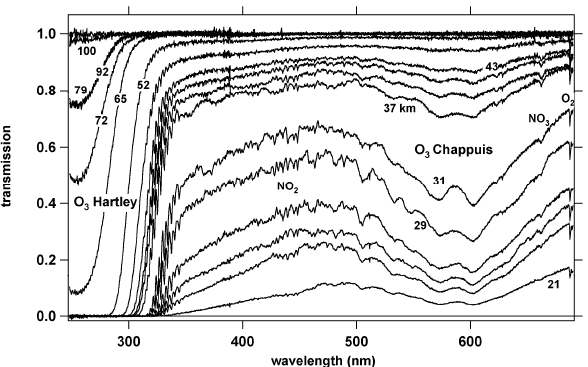
Fig. 12. Atmospheric transmission spectra along the line of sight from GOMOS to the star Sirius, for different tangent altitudes.